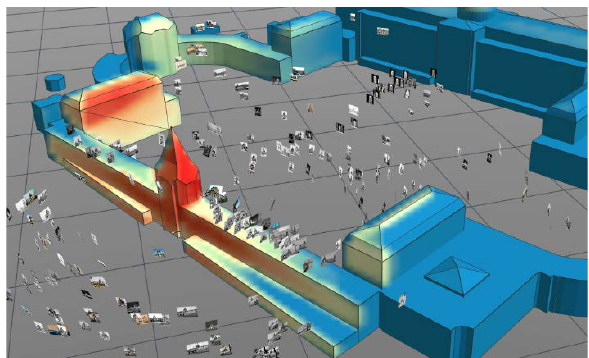
Figure 4. Heat map showing which building parts were often (red) and hardly (blue)